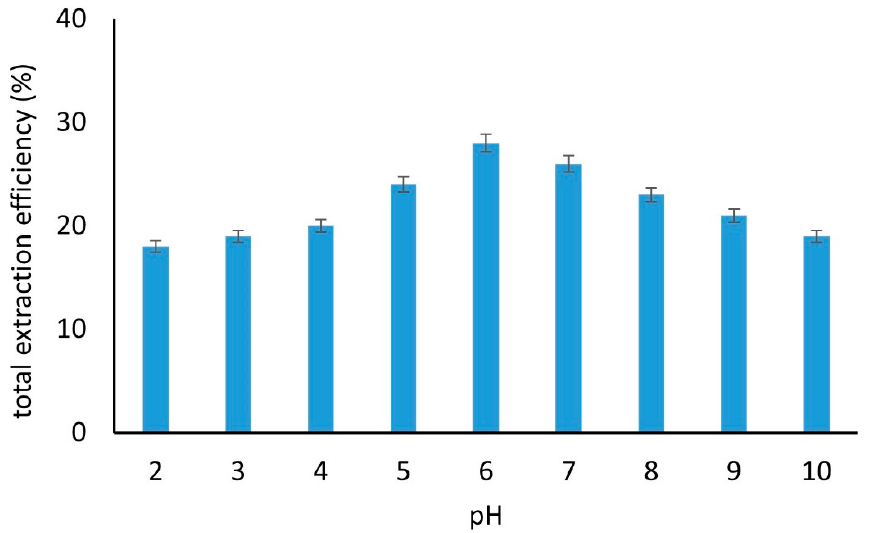
Figure 4. Total extraction efficiency of the examined compounds from solutions with different pH using the GQDs-LDH composite material (number of replicate analyses =